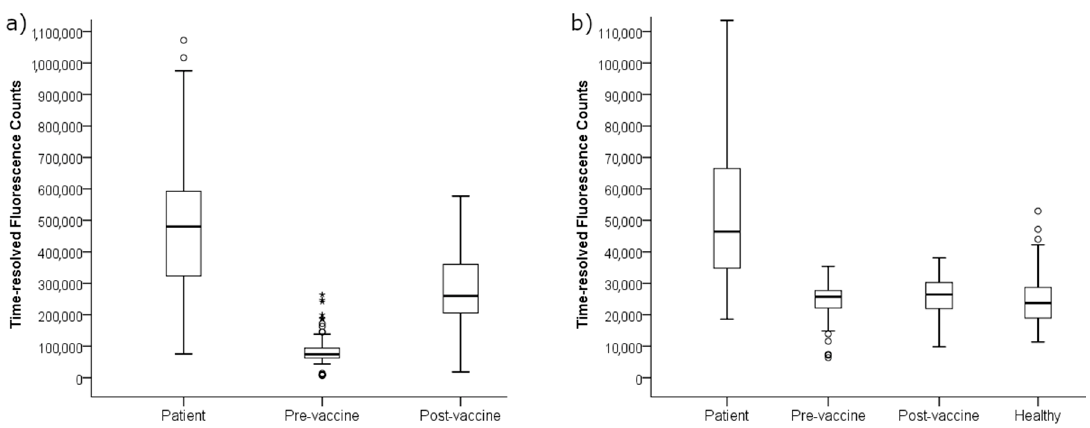
Figure 3. The multiplex antibody readouts from lateral flow test strips were measured as average time-resolved fluorescence signal from two test lines containing ( a ) PT and ( b ) ACT with pertussis patient samples ( n = 46), paired before and one month after vaccination samples ( n = 67) and with healthy controls ( n = 102, only tested with ACT). Two outliers from patients are limited out with over 140,000 counts in Figure ( b ). A significant difference in anti-PT antibodies was noted between pre-vaccination antibodies and both the patients and post-vaccination antibodies ( p < 0.001). Patients had significantly higher anti-ACT antibodies in comparison to other study groups ( p <